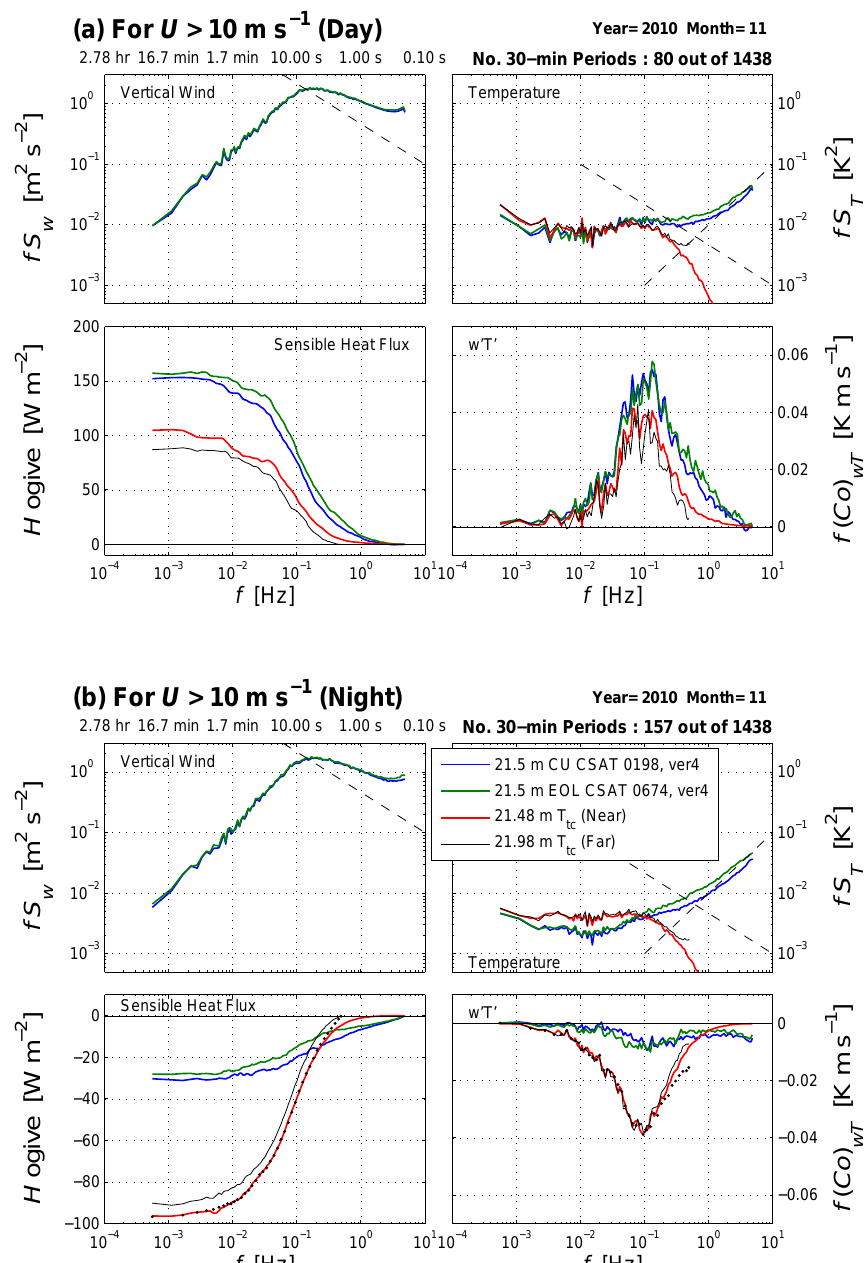
Fig. 3. Mean (a) daytime and (b) nighttime values of vertical wind spectra S w , temperature (either T s or T tc ; see legend and Table 1) spectra S T , w 0 T 0 cospectra Co wT , and sensible heat flux H ogive versus frequency f . These are 30-min periods from November, 2010 selected for wind speed U greater than 10ms − 1 (the number of 30-min periods that match this criterion is listed above the S T panel). Co-spectral analysis between the 1-Hz far thermocouple and 10-Hz w uses w that has been down-sampled to 1Hz by picking samples that are closest to the 1-Hz samples in time. Similarly, the 10-Hz near thermocouple data resampled to 1Hz are shown by the black dots in the Co wT and H ogive panels of (b) . The dashed lines show a f − 2 / 3 and f + 1 slope. Note that the S w lines from the two CSATs are nearly indistinguishable from each